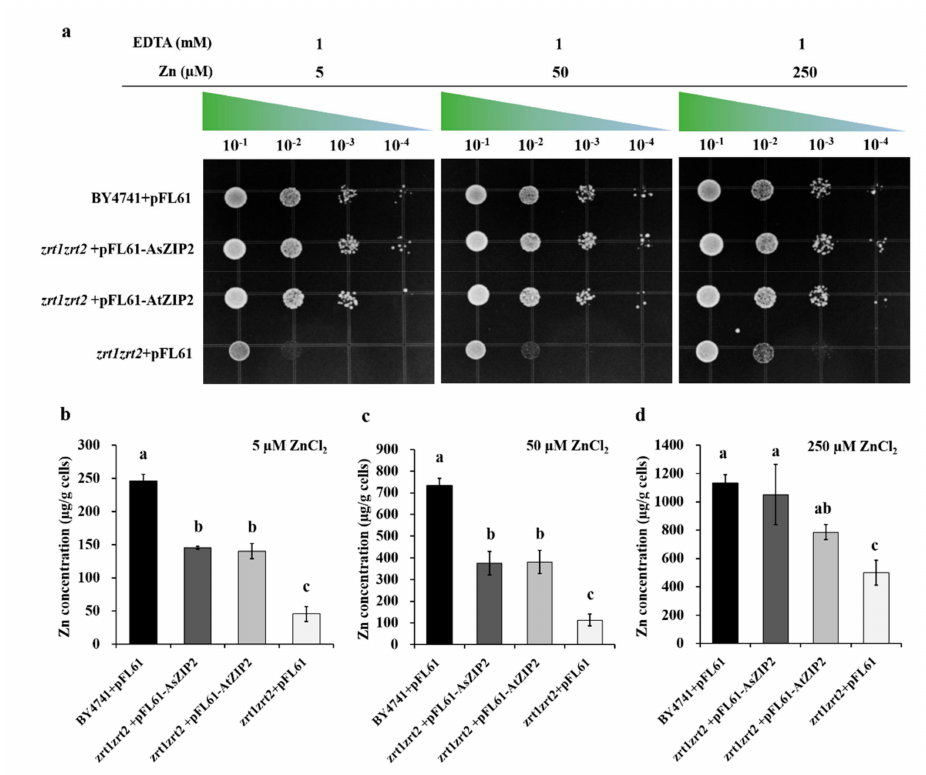
Figure 6. Complementation of Saccharomyces cerevisiae mutant zrt1zrt2 and wild-type strain BY4741. Yeast cells expressing AsZIP2 and AtZIP2 in the vector pFL61 were grown under different Zn concentrations as indicated. ( a ) The wild-type strain BY4741 transformed with pFL61 and Zn ( zrt1zrt2 ) transport mutant carrying AtZIP2 were used as the positive controls, while the mutant zrt1zrt2 carrying pFL61 was applied as a negative control. The mutant zrt1zrt2 transformed with AsZIP2 was used for validation. Transformed cells were grown on SD medium without uracil (SD/-ura) and plus 1 mM EDTA and 5, 50, or 250 µ M ZnCl 2 . The gradient marks above each panel indicate cell dilutions from 10 − 1 to 10 − 4 . For tests, 5- µ L drops of each dilution was spotted on solid SD/-ura media and grown for 2 days at 30 ◦ C. ( b – d ) Zn concentrations in the yeast mutant zrt1zrt2 strain expressing AsZIP2 , AtZIP2 , or pFL61 vector and in wild-type BY4741 with pFL61 , grown under 5 ( b ), 50 ( c ), or 250 µ M ( d ) ZnCl 2 conditions. The Zn concentrations in yeast cells grown in SD/-ura media as shown in Figure 6b–d. The data are expressed as µ g Zn per g cell dry weight. Error bars represent the SD for means of three independent experiments. Different letters indicate significant differences at p < 0.05, based on the Duncan’s multiple range